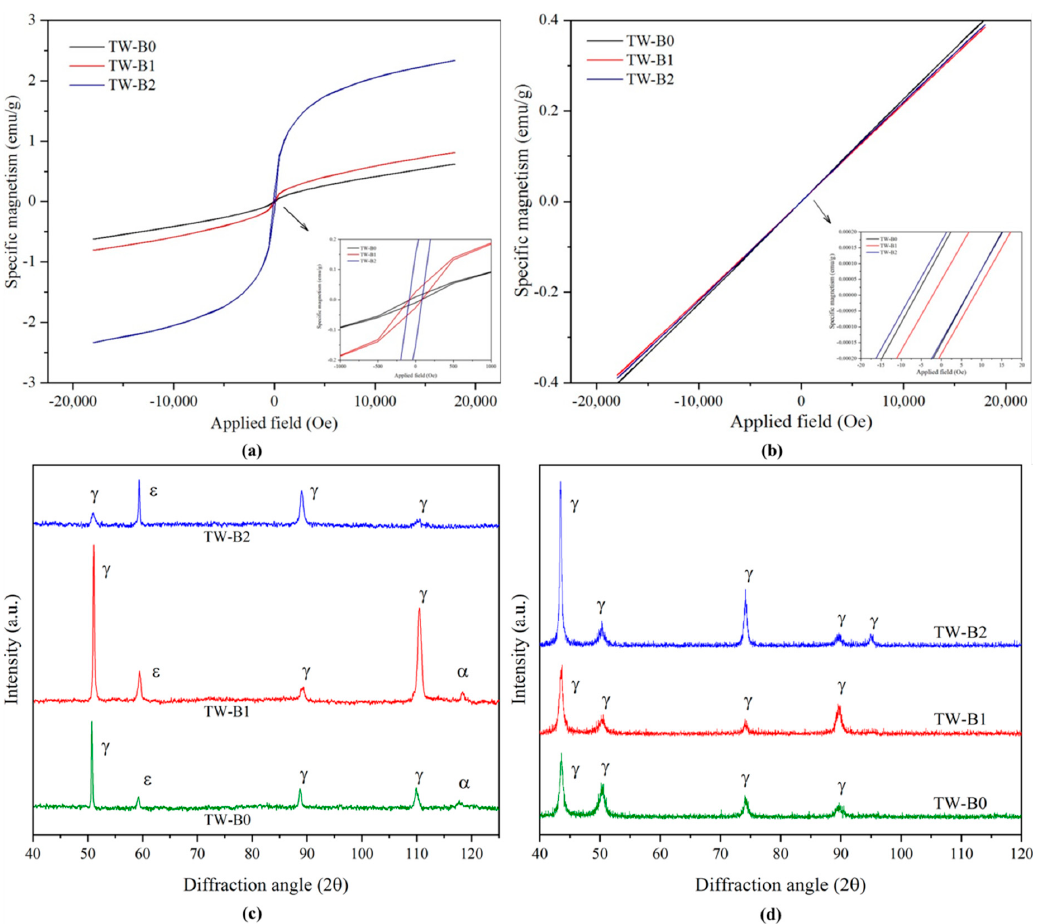
Figure 10. ( a , b ) Magnetic behavior of TWIP steels in the as-cast and as-cold-rolled conditions, respectively; ( c , d ) X-ray patterns of TWIP steels in the as-cast and as-rolled conditions, respectively.